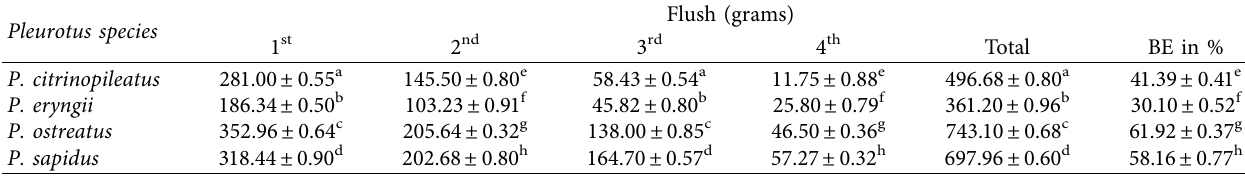
Table 5: Yield and biological efficiency of the four Pleurotus species on composted coffee husks substrate. Pleurotus species